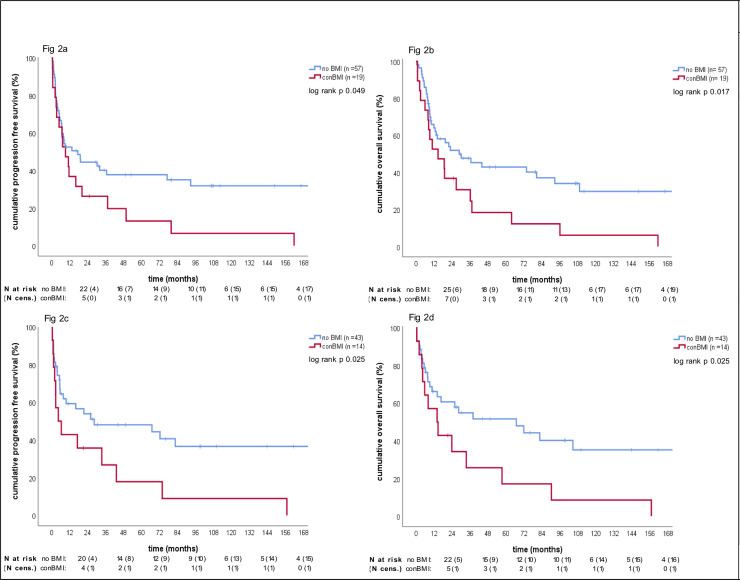
Kaplan-Meier curves for progression free survival and overall survival according to different groups of BMI.a: KM curve for PFS according to noBMI vs conBMI in the total cohort; b: KM curve for OS according to noBMI vs conBMI in the total cohort; c: KM curve for PFS landmark analysis according to noBMI vs conBMI in the transplanted patient subset; d: KM curve of OS landmark analysis according to noBMI vs conBMI in the transplanted patient subset; Abbreviations: BMI: bone marrow infiltration, noBMI: no bone marrow infiltration, conBMI: concordant bone marrow infiltration, KM: Kaplan-Meier; PFS: progression free survival, OS: overall survival, N: number of patients, cens.: censored.